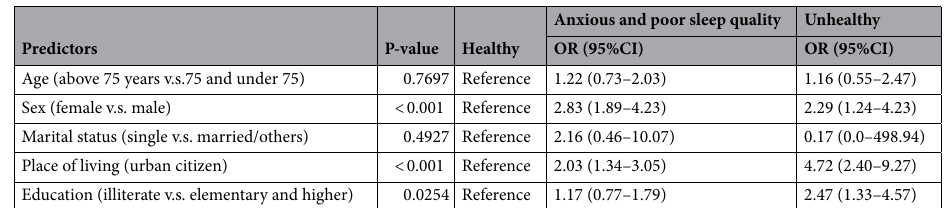
Anxious and poor sleep quality